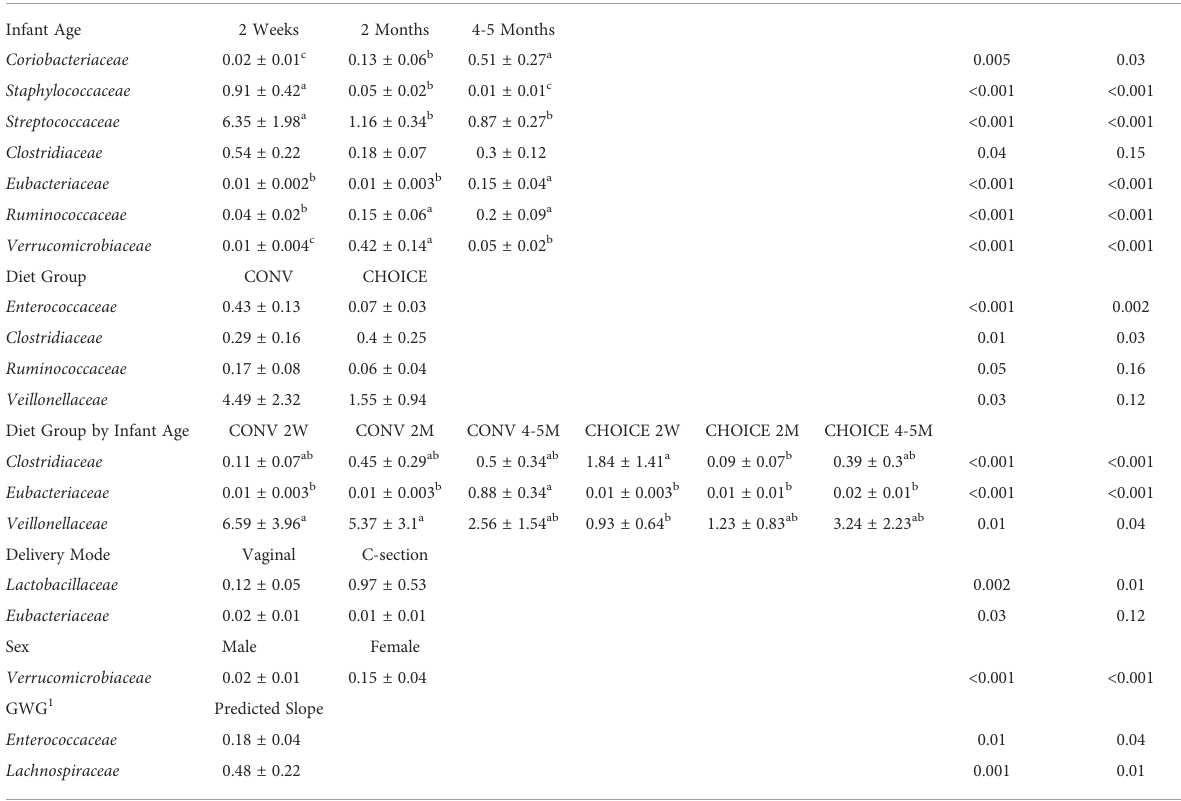
TABLE 5 Variables associated with infant family-level taxa determined by negative binomial regression.